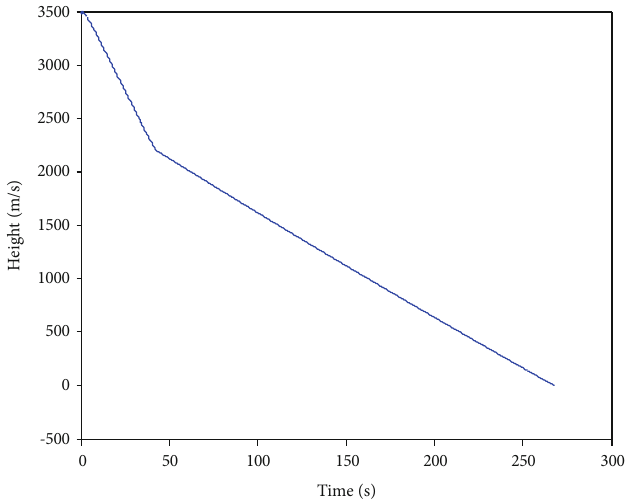
Figure 6: Height-time diagram.